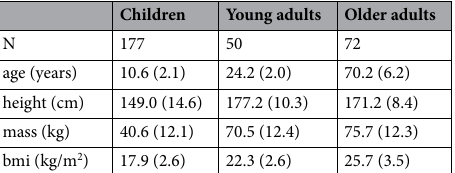
Table 2. Descriptive characteristics of each age group (standard